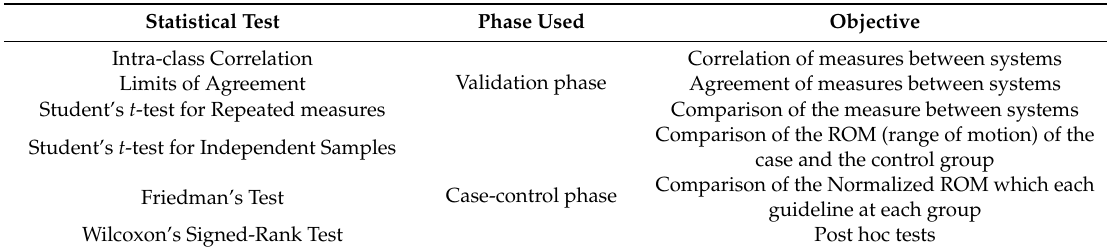
Table 1. Statistical tests